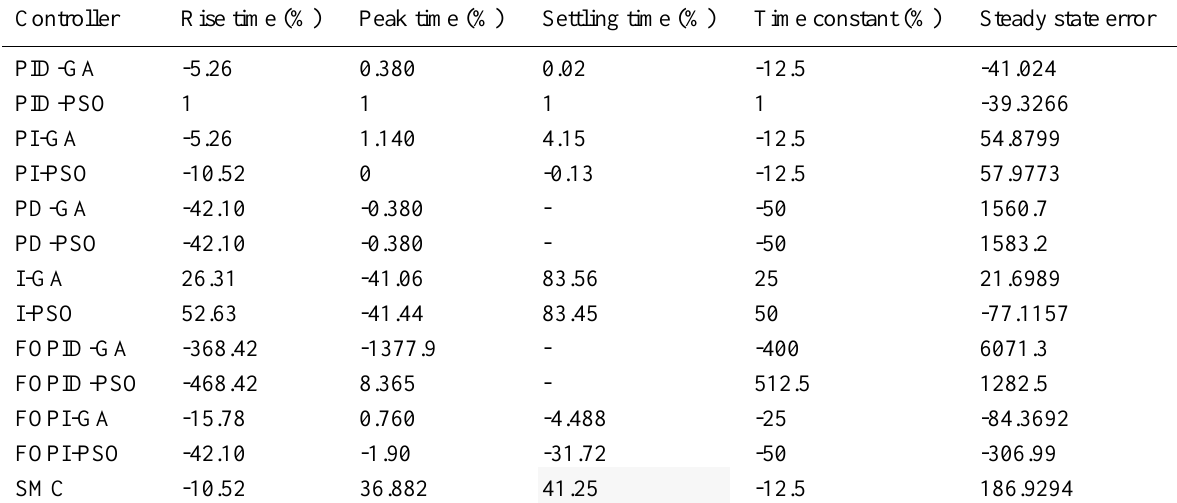
Table 2 Performance index of all the optimized